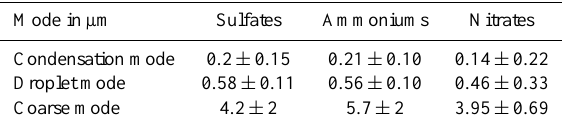
Table 5. Mass mean aerodynamic diameter of the distribution modes from Zhuang et al.